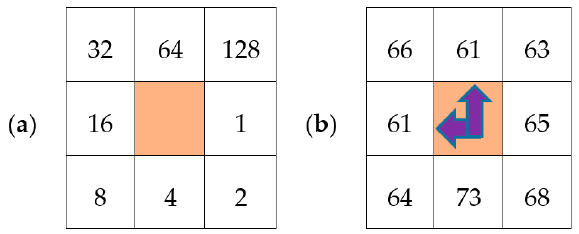
Figure 2. Flow direction [24]. ( a ) Steepest drop direction chart; ( b ) for example, on the right side, the steepest drop is 61 and its direction values are 16 and 64; therefore, the center pixel has the 16 + 63 = 80 value.